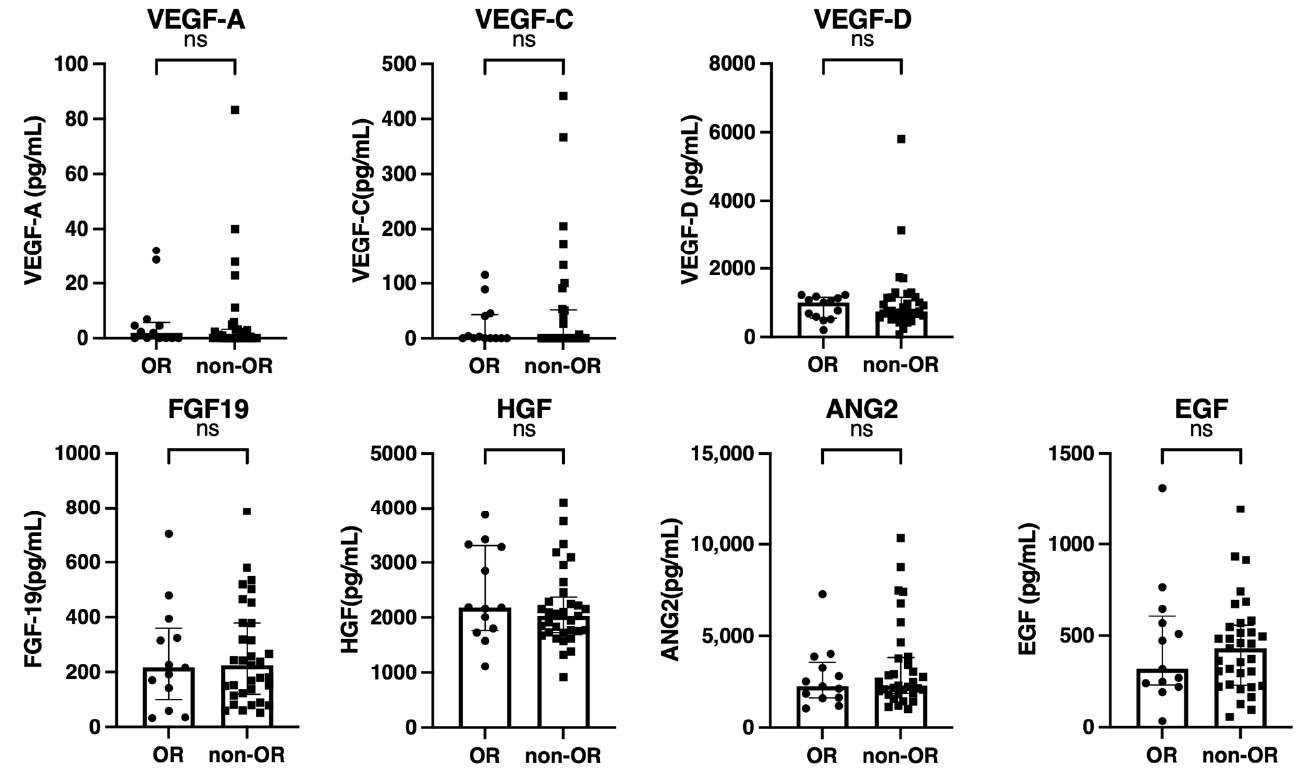
Figure 3. Comparison of the baseline growth factors between patients with and without an objective response (OR) ( n = 46). Baseline serum VEGF-A, VEGF-C, VEGF-D, FGF-19, HGF, ANG-2, and EGF levels were compared between patients with and without an OR. The bar graph shows the median serum growth factor levels with an interquartile range indicating the error bars. ns, not significant; VEGF, vascular endothelial growth factor; FGF-19, fibroblast growth factor-19; HGF, hepatocyte growth factor; ANG-2, angiopoietin-2; EGF, epidermal growth factor. 3.3. Changes in Growth Factors between Baseline and Best Overall Response Point in Unresectable HCC Patients with Disease Control by Atezolizumab Plus Bevacizumab Next, the changes in growth factors between the baseline and best overall response points in 32 patients who achieved CR ( n = 4), PR ( n = 9), or SD ( n = 19) were analyzed. As shown in Figure 4, the FGF-19 level was significantly increased at the best overall response point; in contrast, the ANG2 significantly decreased at the best overall response point. 3.4. Changes in Growth Factors between the Best Overall Response Point and PD Point in Unresectable HCC Patients with Disease Control by Atezolizumab Plus Bevacizumab Finally, we analyzed the changes in growth factors between the best overall response point and PD point in 28 patients who achieved disease control with atezolizumab plus bevacizumab; however, they subsequently experienced PD (Table 3, Figure 1). As shown in Figure 5, the VEGF-D and ANG2 levels were significantly increased at the PD point compared to that at the best overall response